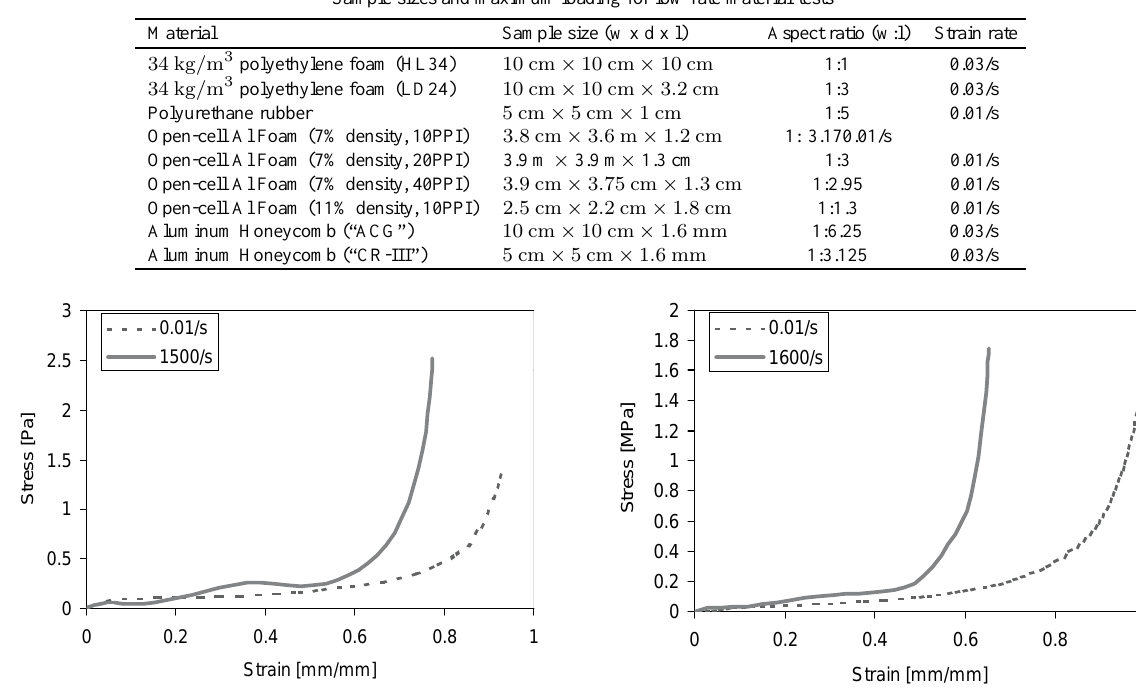
Table 1 Sample sizes and maximum loading for low-rate material tests